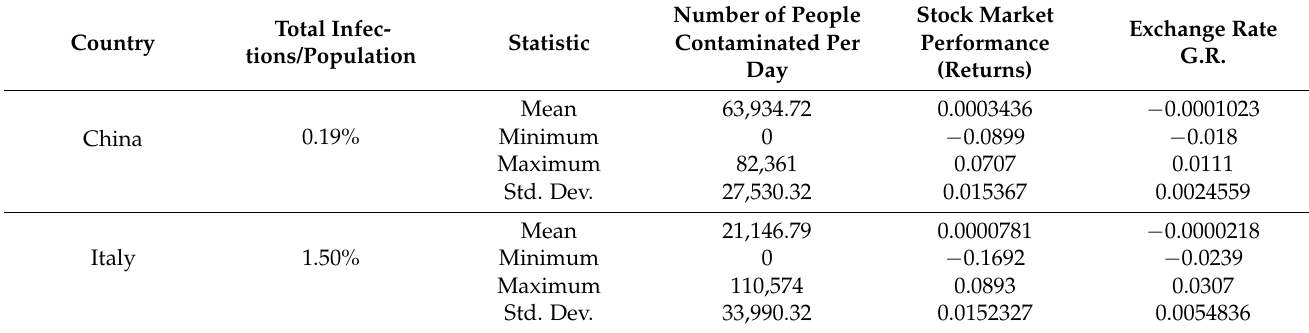
Table 3. Basic statistics by